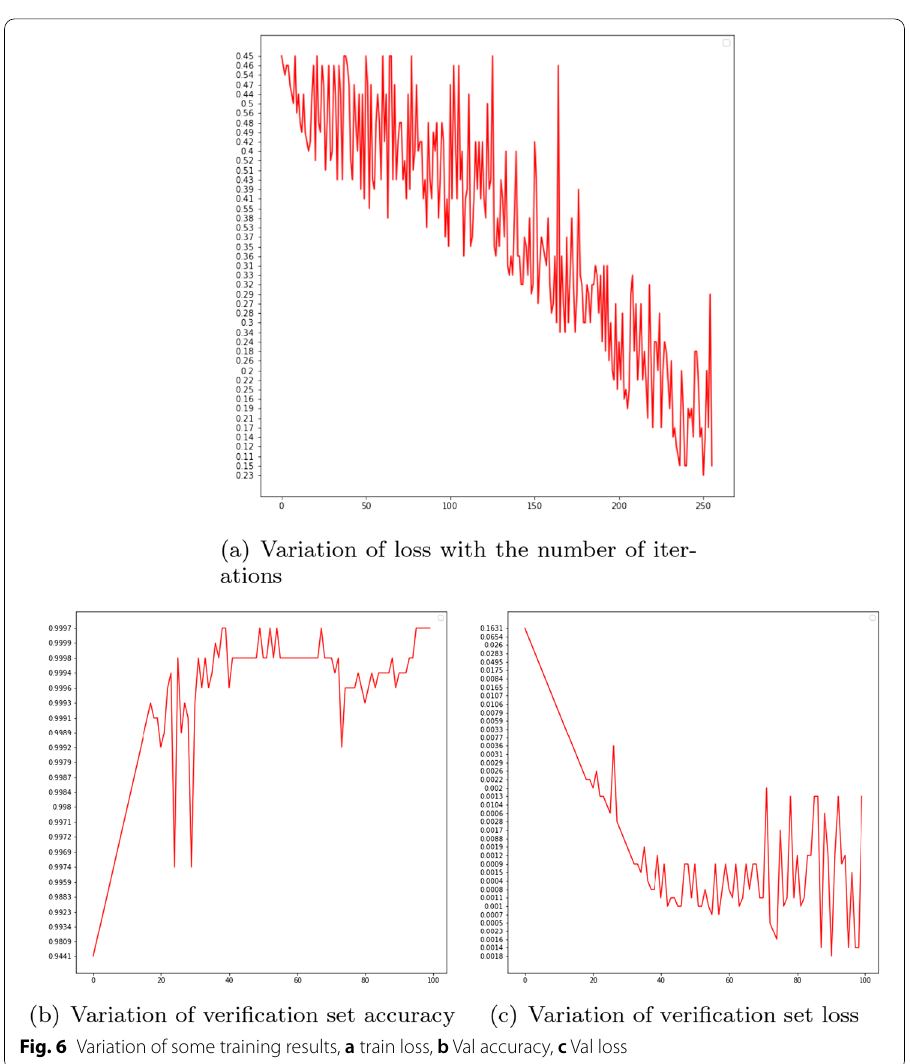
Fig. 6 Variation of some training results, a train loss, b Val accuracy, c Val loss